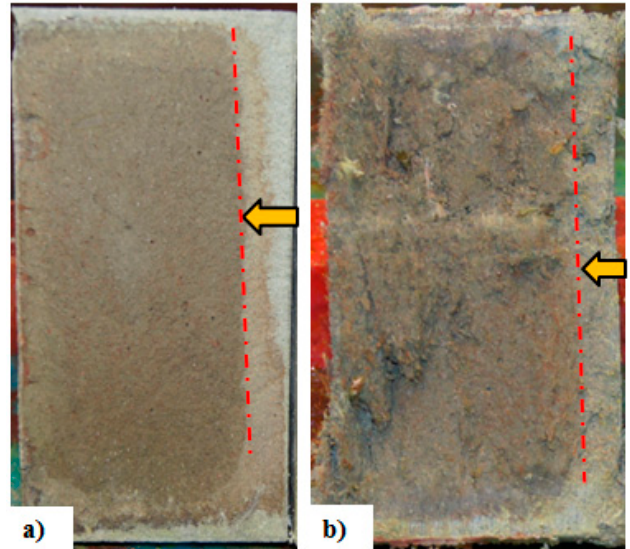
Figure 3. Chloride penetration depth in ( a ) mortar and ( b ) SHCC specimens after a rapid chloride migration test (note: arrows represent the chloride penetration direction).